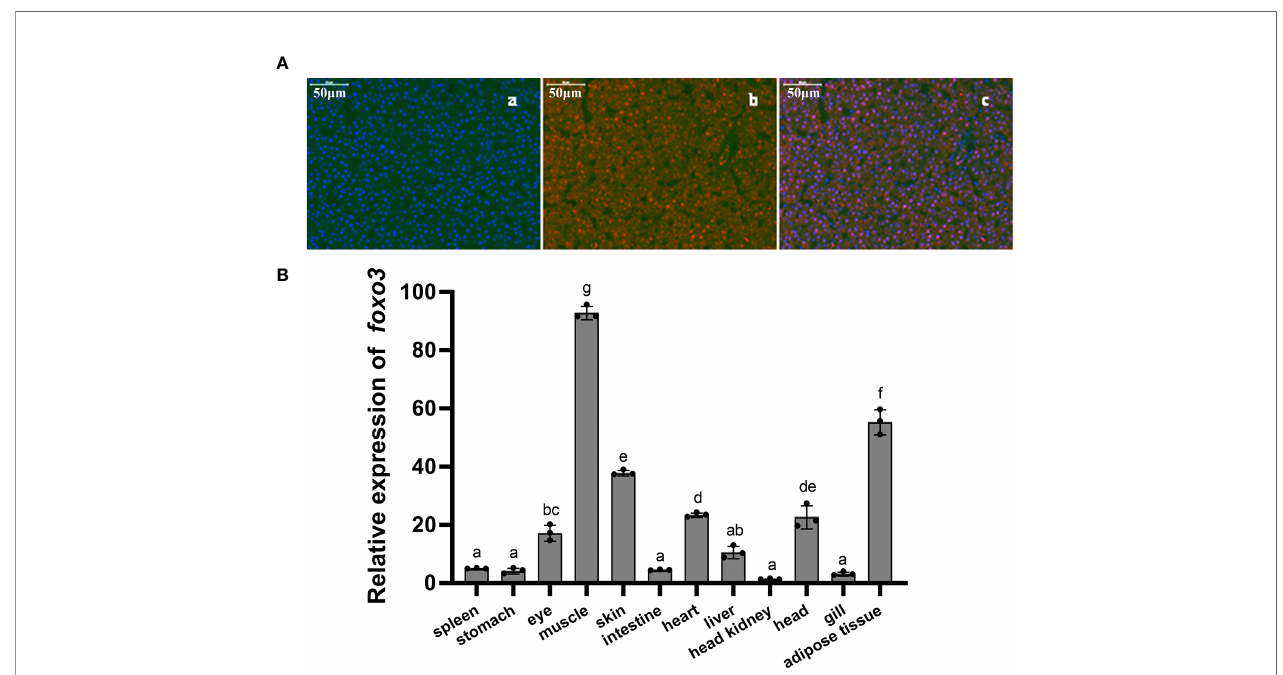
FIGURE 2 | (A) Immuno fl uorescent localization of FoxO3 in turbot liver. (a) DAPI staining; (b) FoxO3 staining; (c) Merge. (B) Expressions of foxo3 in different tissues of turbot. The results were expressed as the mean ± standard deviation (n = 3). Bars bearing the different letters are signi fi cantly different between tissues by one- way analysis of variance (ANOVA) ( P < 0.05).